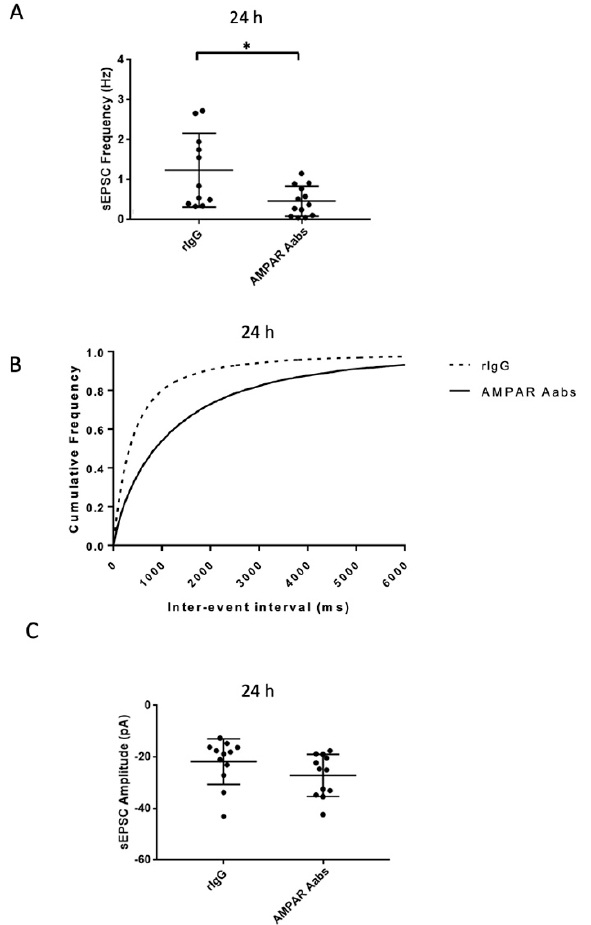
Figure 4. Effects of 24 h anti-AMPAR Aabs and rIgG application on sEPSC frequency and ampli-